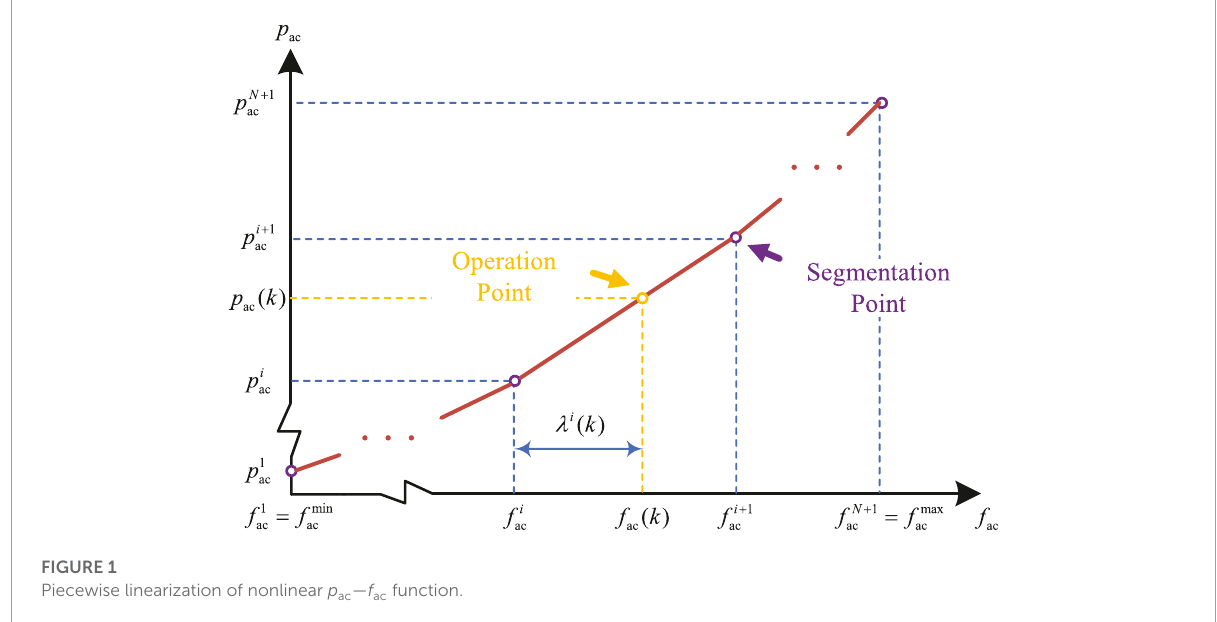
FIGURE 1 Piecewise linearization of nonlinear p ac — f ac function.